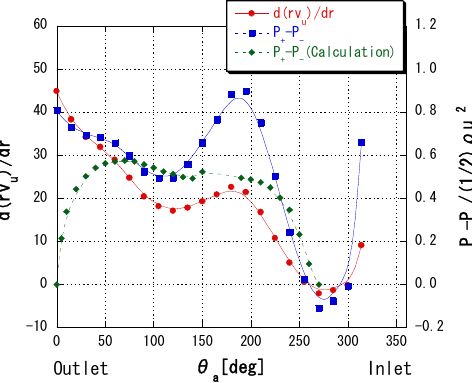
Fig. 11 Total pressure distributions ( φ =0.025)